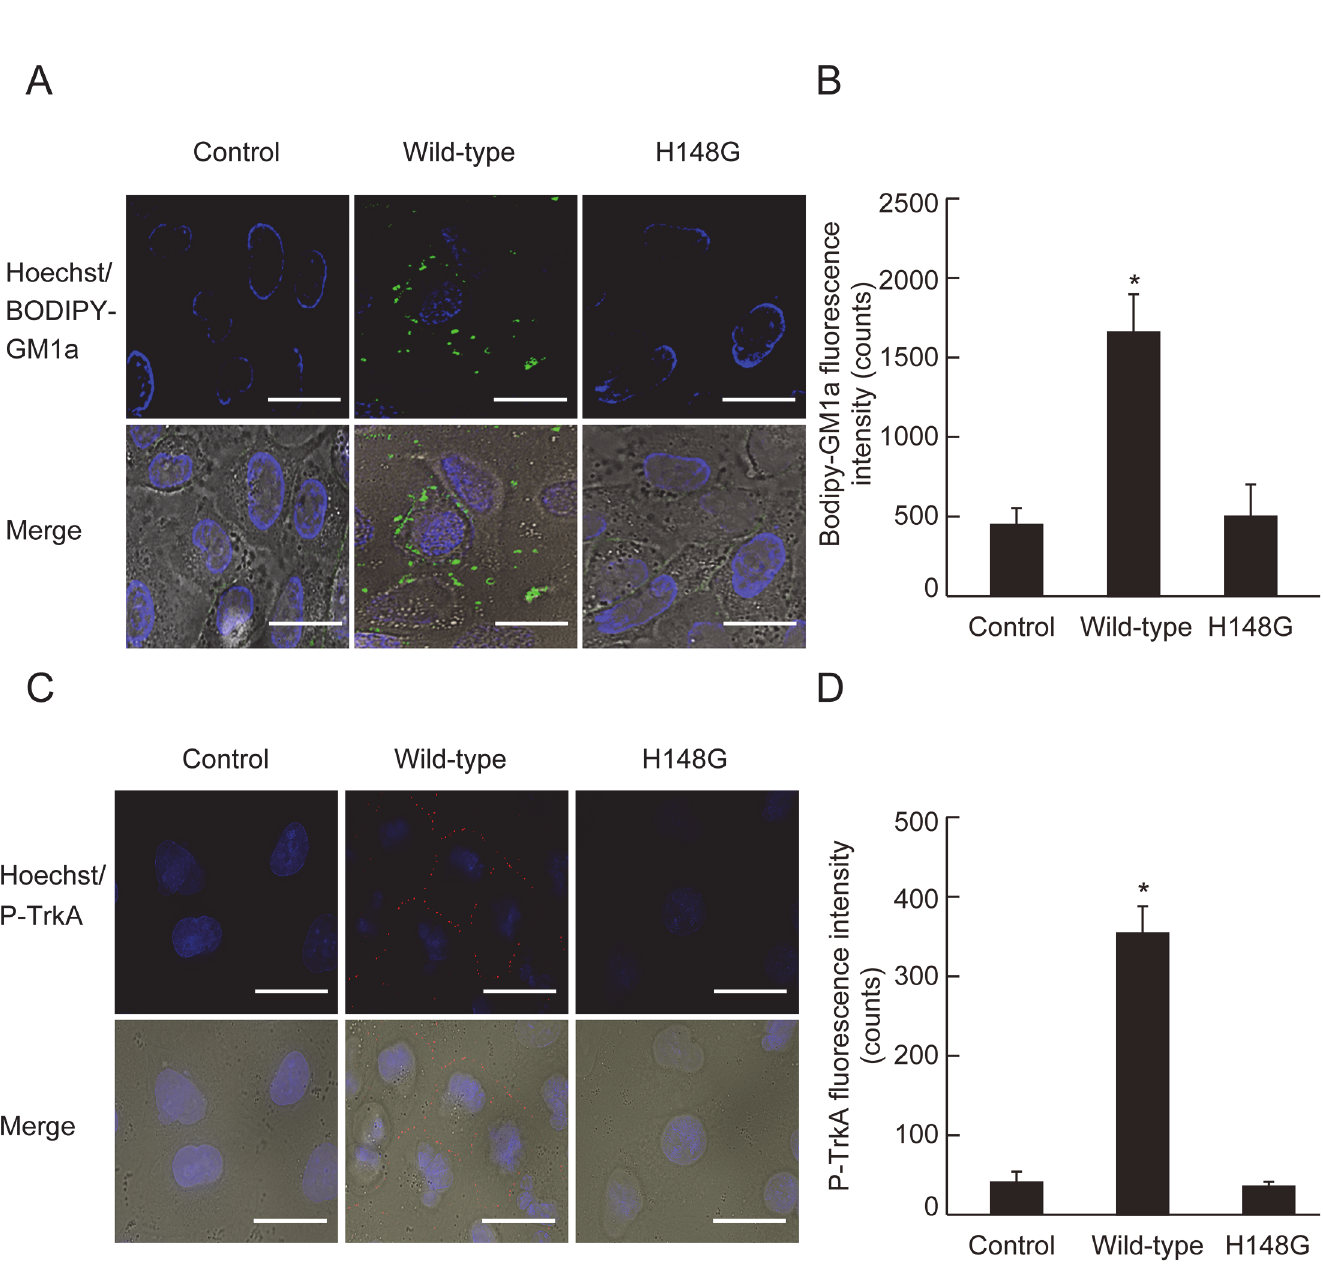
Fig 3. Clustering of GM1a and phosphorylation of TrkA in the membrane of cells treated with alpha-toxin. (A) A549 cells stained with BODIPY-GM1a were incubated with 1.0 μ g/mL wild-type alpha-toxin or H148G alpha-toxin at 37°C for 60 min. The cells were fixed in 4% paraformaldehyde and stained with Hoechst 33342. GM1a (green) and nuclei (blue) were visualized by fluorescence microscopy. Scale bar, 10 μ m. (B) Bodipy-GM1a fluorescence intensity was measured as described in Materials and Methods. Values represent the mean ± SE; n = 3; * , p < 0.01. (C) A549 cells were incubated with 1.0 μ g/mL wild- type or H148G alpha-toxin at 37°C for 60 min. The cells were fixed, permeabilized, and stained with phospho-TrkA antibody and Hoechst 33342. Phospho- TrkA (red) and nuclei (blue) were visualized by fluorescence microscopy. Scale bar, 10 μ m. (D) Phospho-TrkA fluorescence intensity was measured as described in Materials and Methods. Values represent the mean ± SE; n = 5; * , p <